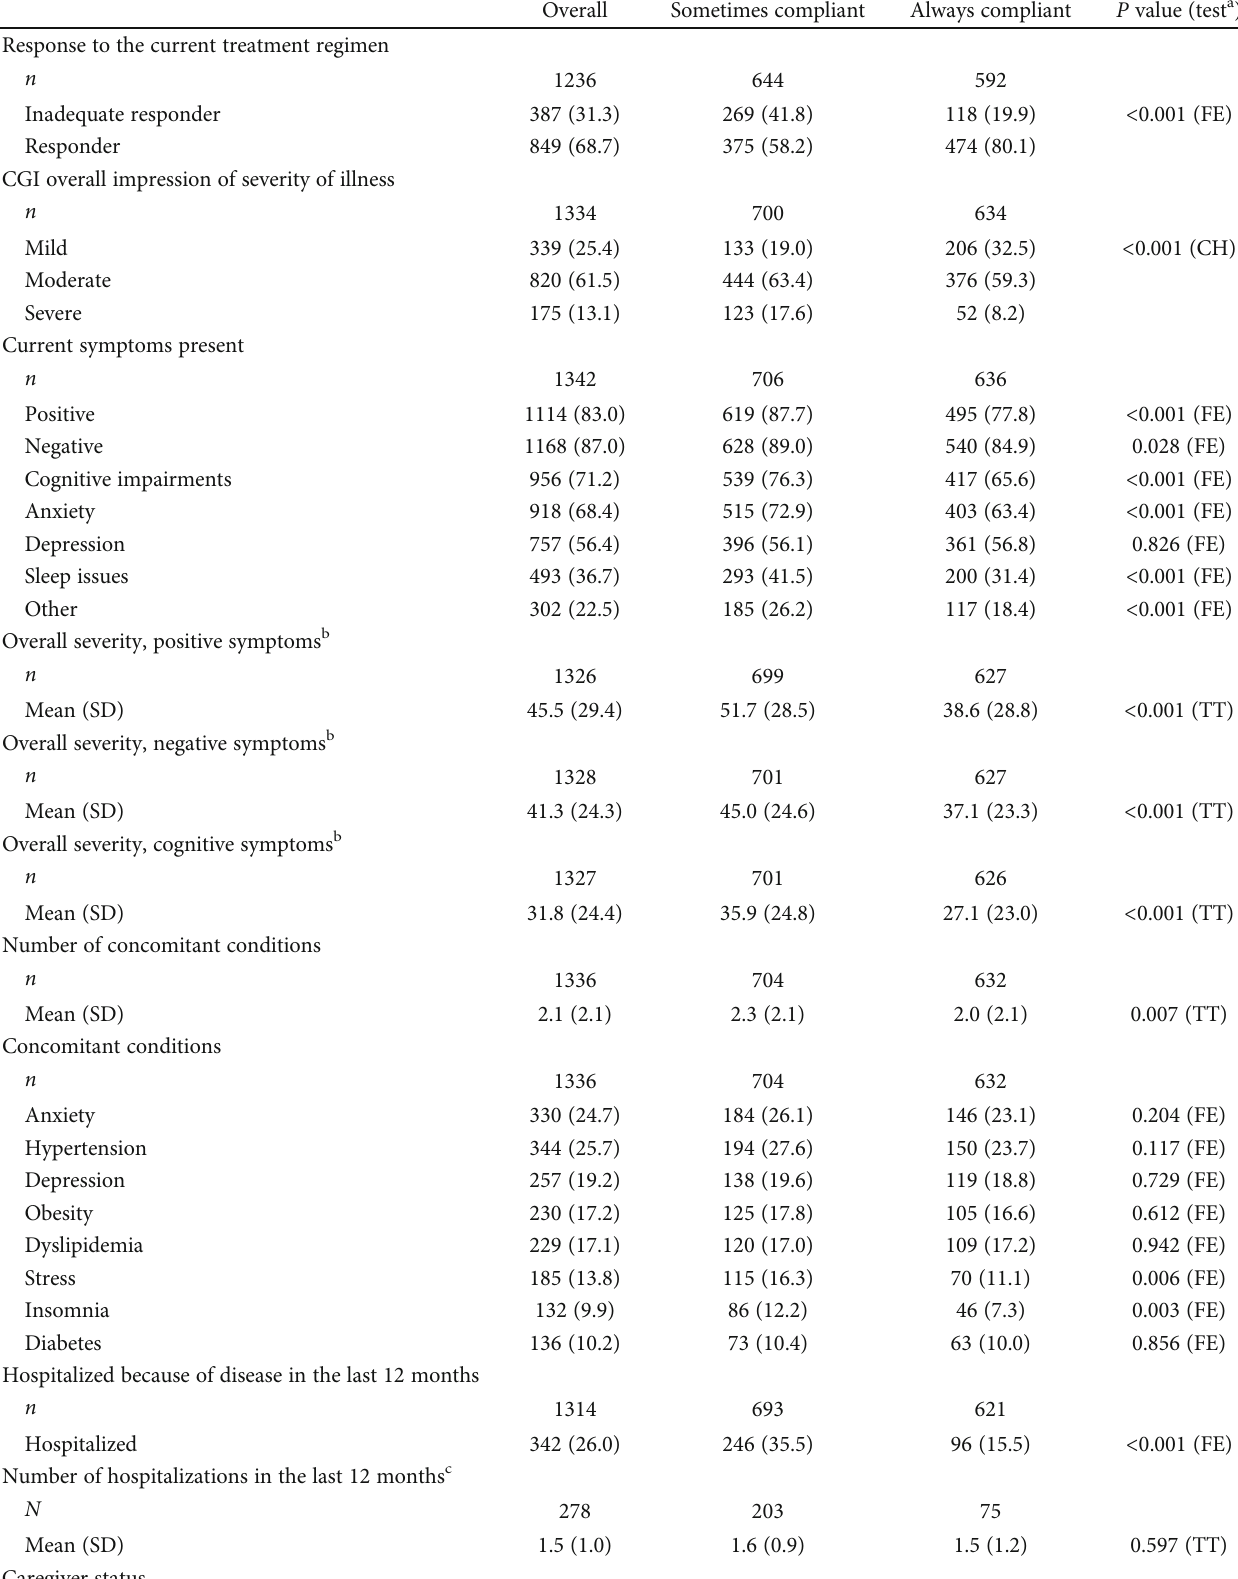
Table 2: Patient clinical characteristics and